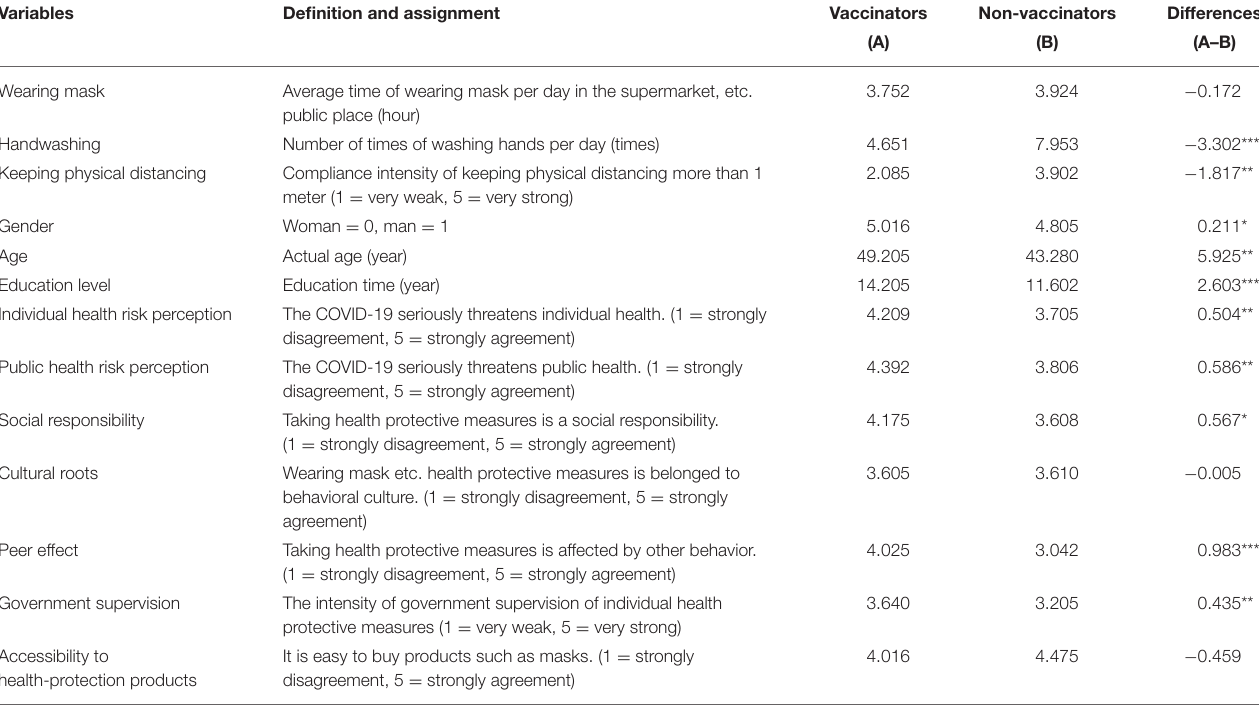
TABLE 1 | Variables’ differences between vaccinators and